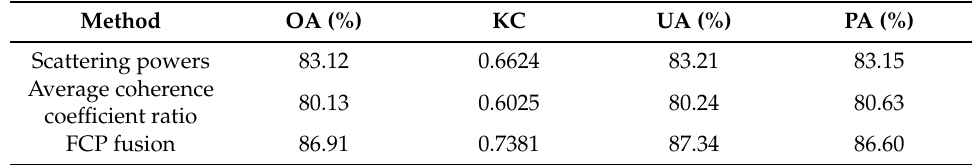
Table 4. Accuracy assessment of the detection result in Figure 9.